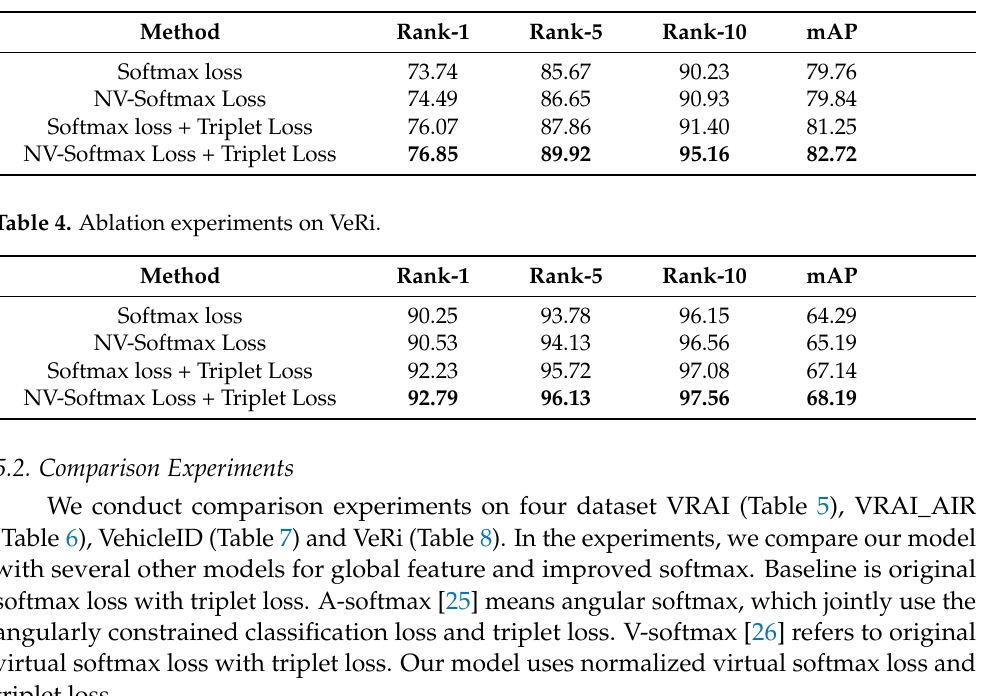
Table 3. Ablation experiments on VehicleID.